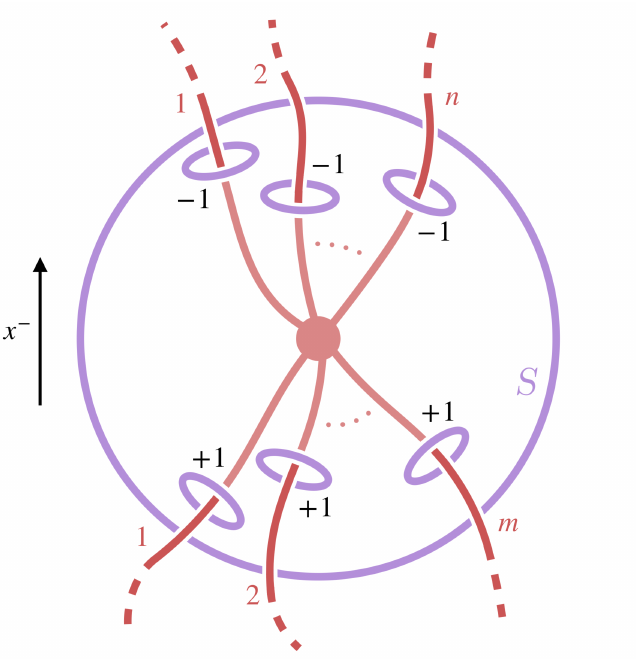
Figure 6 . A general transition point, with Q ( S ) = m − n on a small 4-sphere S surrounding